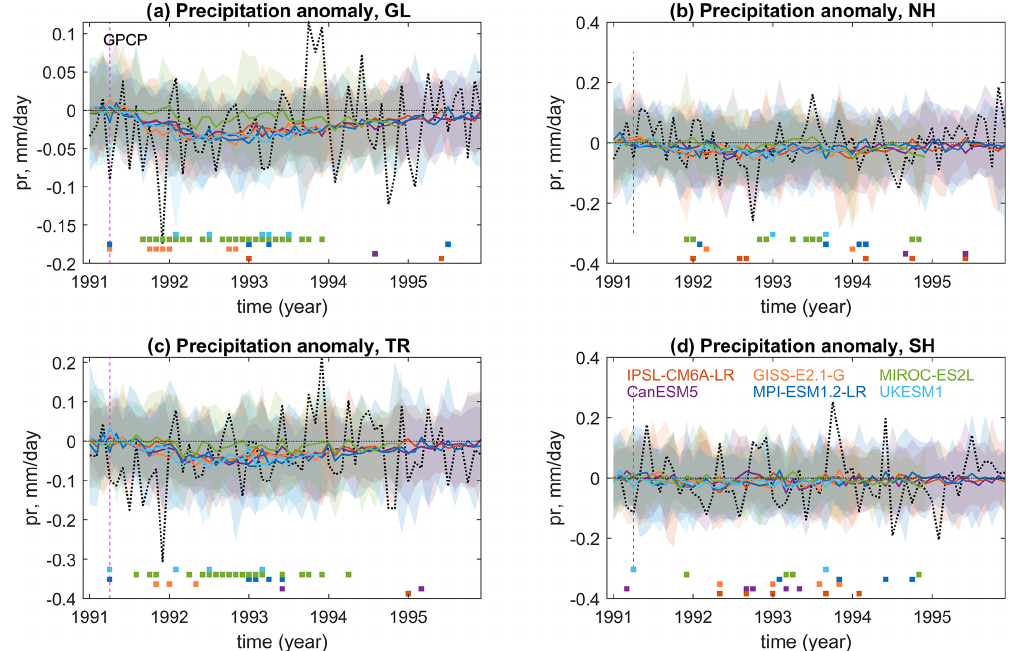
Figure 8. Same as in Fig. 5 but for anomalies of total precipitation (pr). Observed GPCP anomalies (ensemble-means as deviations from the 1990 average calculated from detrended time series, see methods) are plotted as dotted black lines for